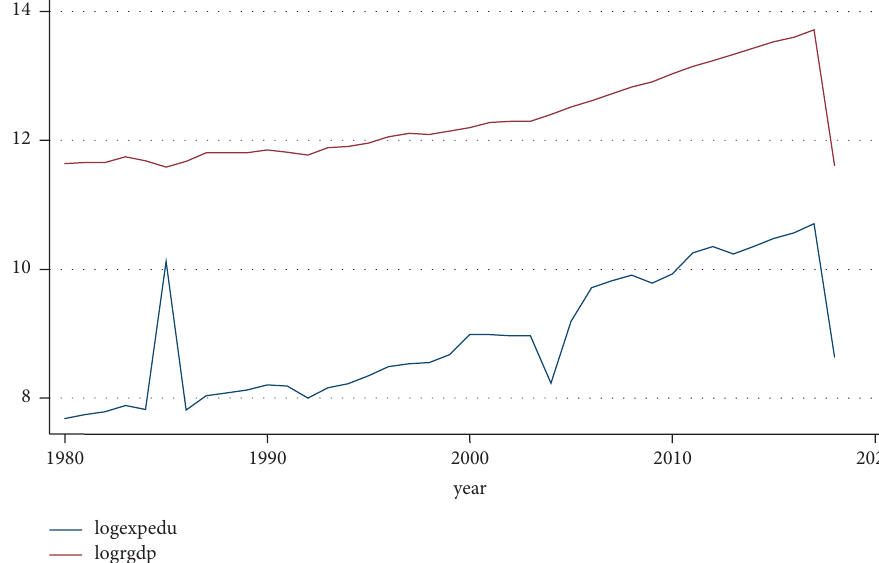
Figure 5: Trend educational expenditure and RGDP. Source: own computation based on the data from MOFED and National Bank,